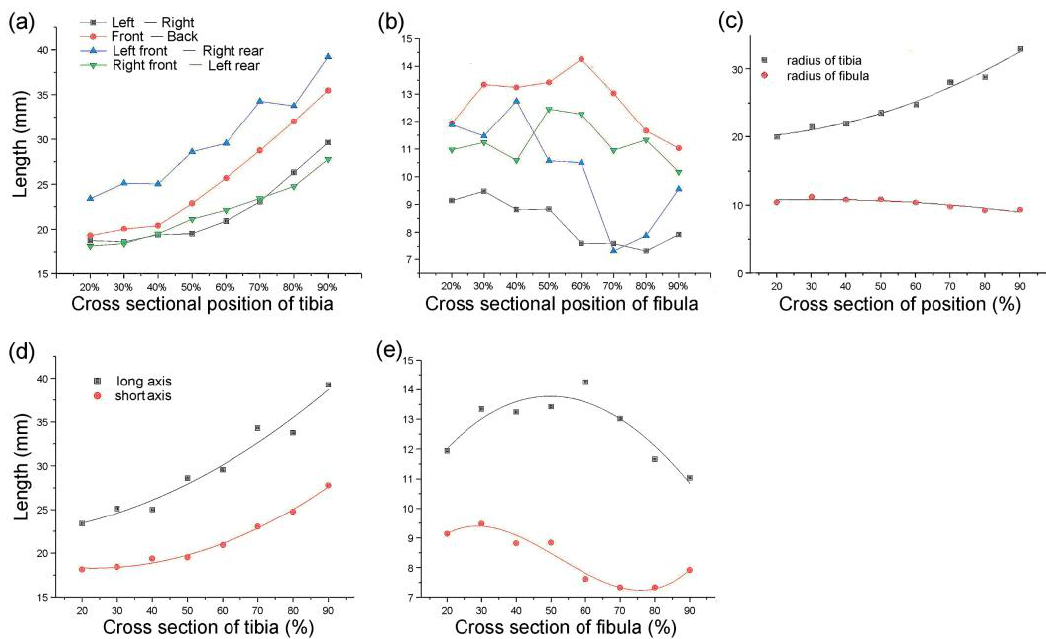
Figure 3. Parameters of tibiofibular section: ( a , b ) dimension data of four straight lines at different cross-sections of the tibia ( a ) and fibula ( b ); ( c ) radius-size data of the tibia and fibula at different sections; ( d , e ) size data of the longest and shortest lines at different sections of the tibia ( d ) and fibula ( e ).